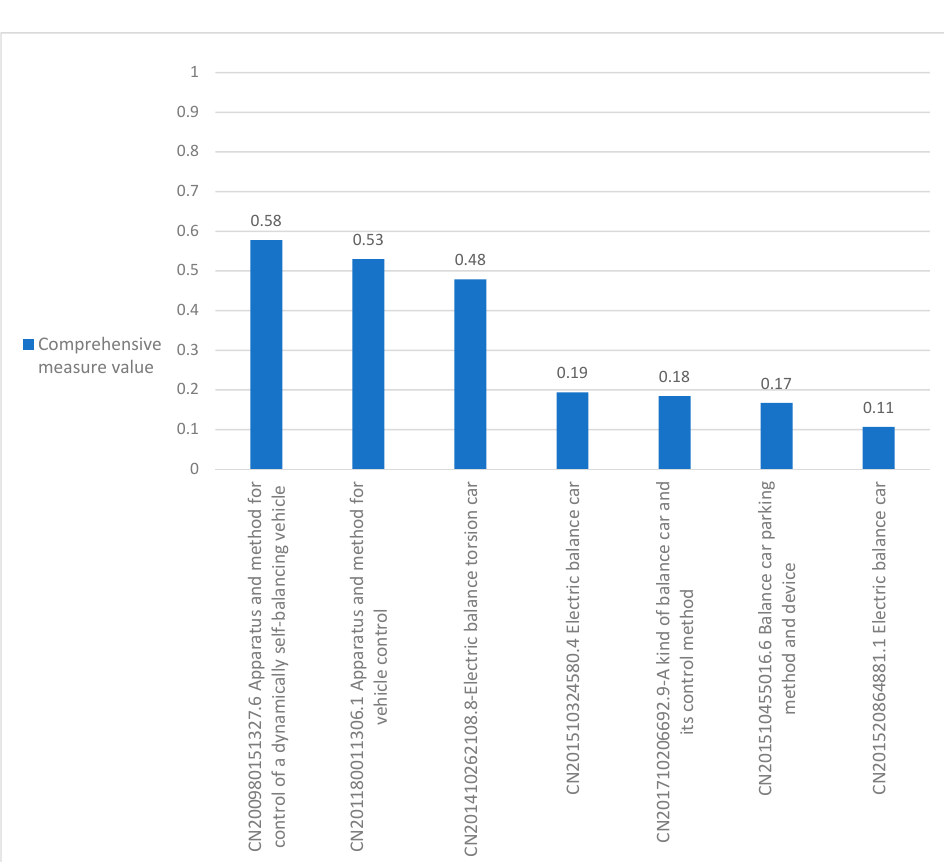
Figure 7. Histogram of the measurement results of the top three and bottom four.